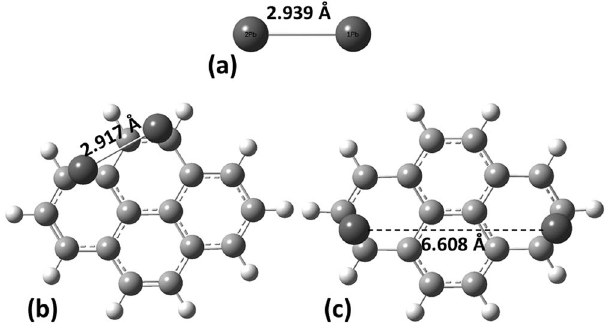
Figure 8. Equilibrium configuration of Pb 2 dimer in vacuum ( a ) and optimized geometries for two Pb atoms on C 16 H 10 GQDs pre-adsorbed at short ( b ) and long ( c ) initial distances from one another,